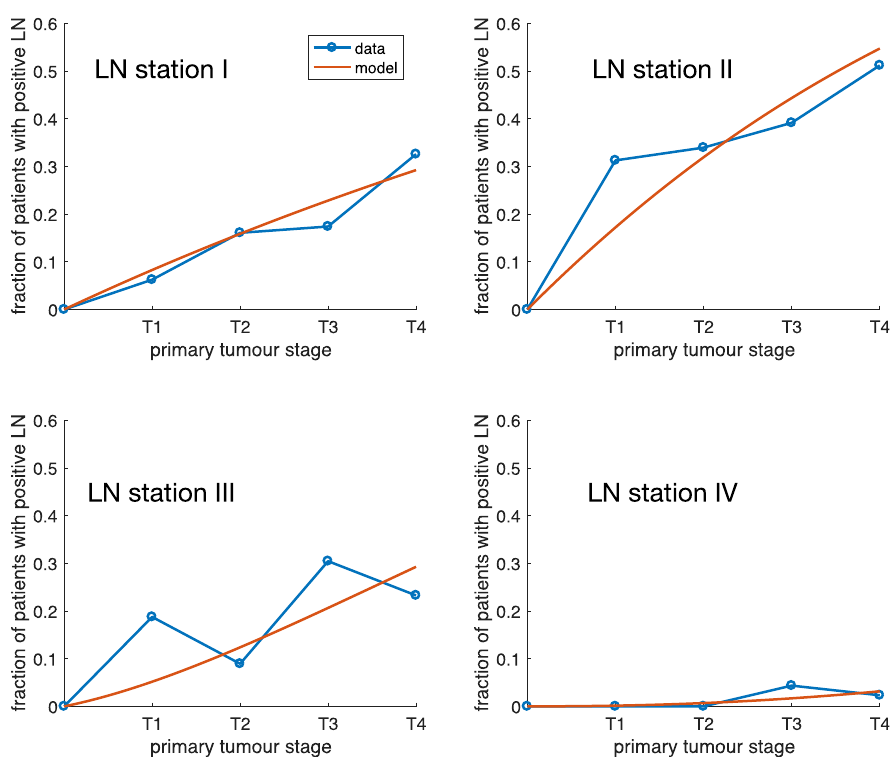
Fig 2. The data and model predictions for metastatic spread to lymph node station I-IV for primary tongue cancer. Each panel corresponds to a lymph node station and shows the probability of finding a metastases in the lymph node as a function of the primary tumour stage. The parameters of the model are given in Table